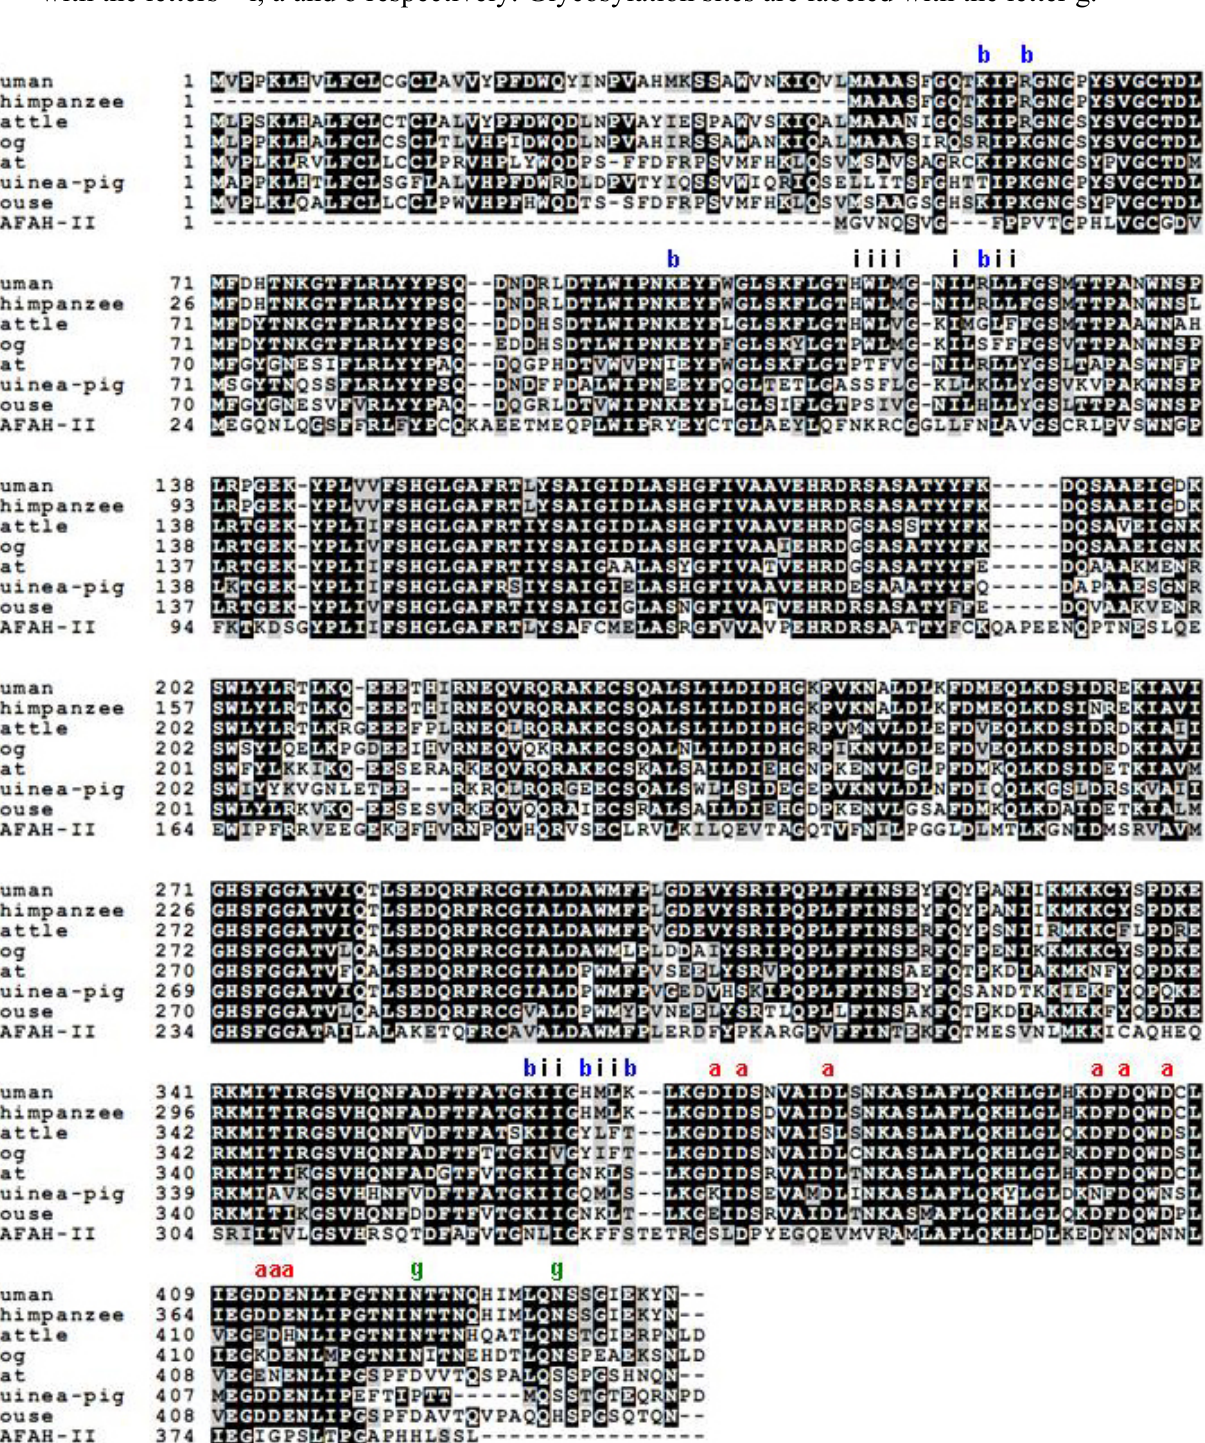
Figure 3. Alignment of PAF-AH amino acid sequences from different mammals. Amino acid sequence of human PAF-AH II is also included for comparison. Amino acids comprising the i-face, acidic patch and basic patch regions of plasma PAF-AH are labeled with the letters – i, a and b respectively. Glycosylation sites are labeled with the letter